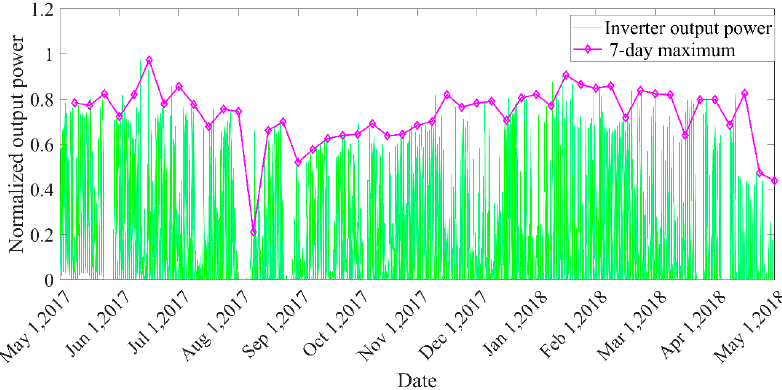
Figure 6. Normalized output power and weekly maximum of an inverter throughout a year.